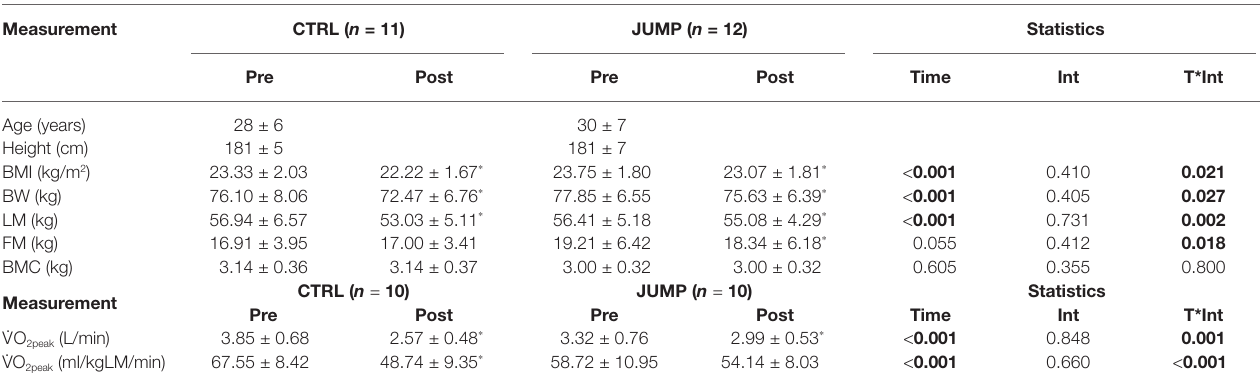
TABLE 1 | Effects of 60 days HDT bed rest on measures of anthropometry and cardiorespiratory capacity.